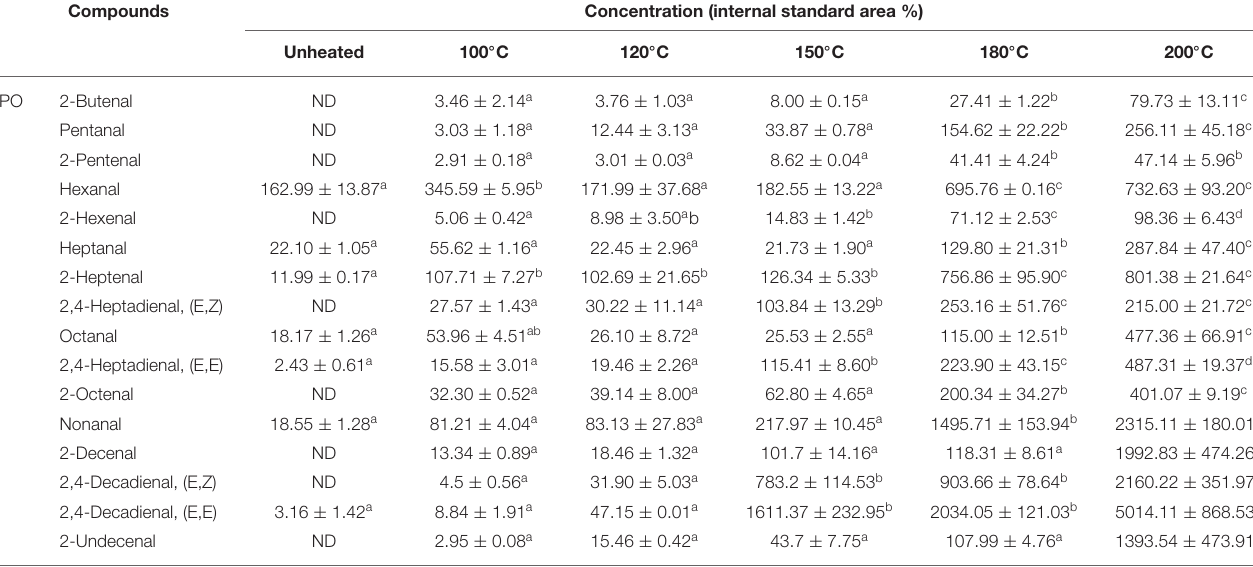
TABLE 4 | Changes in the volatile oxidation products of PO at different heating